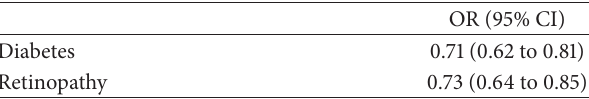
Table 3: Odds ratios (OR) and 95% confidence intervals (CI) for associations of FGF21 with diabetes (𝑛 = 117) and retinopathy (𝑛 = 83) .